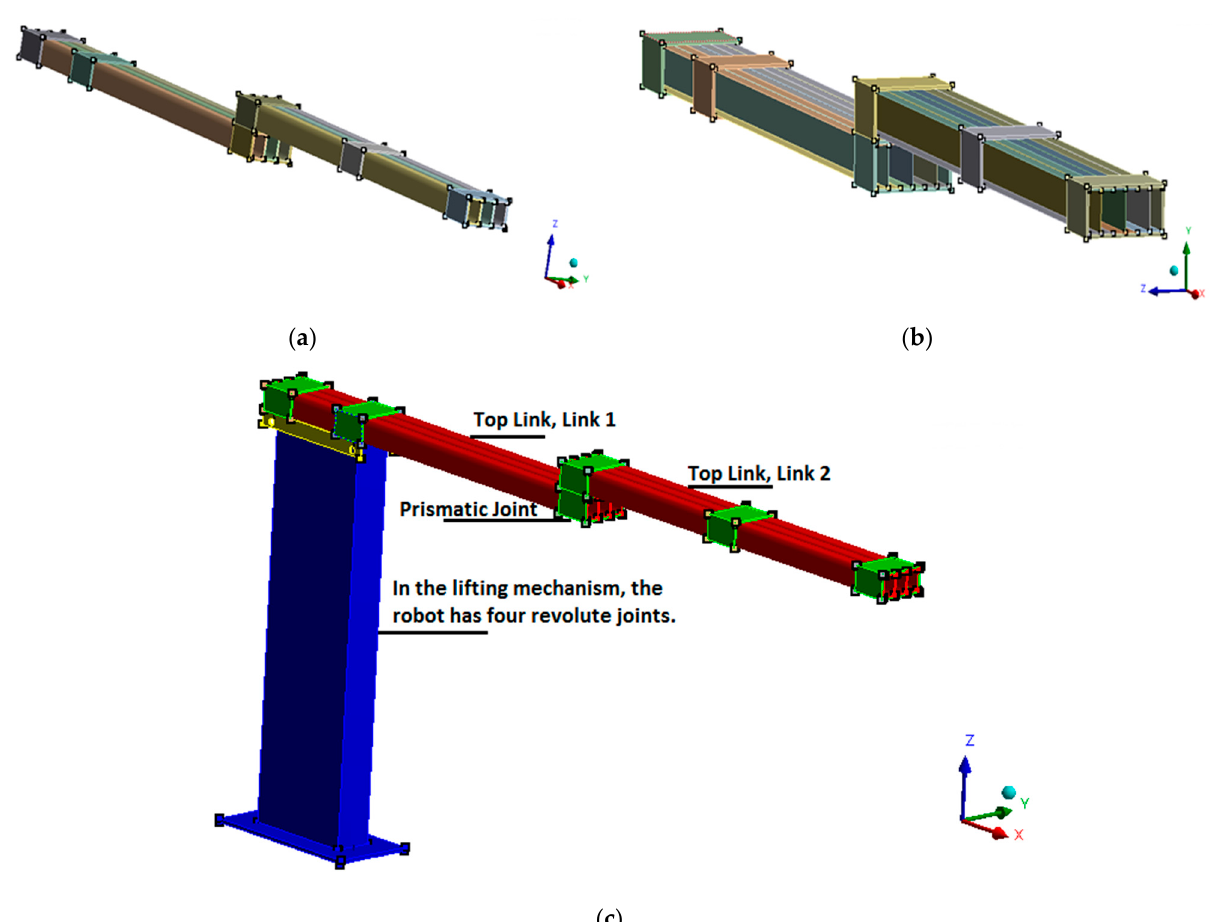
Figure 1. Schematic of the 5 ‐ DOF robot manipulator and its parts: ( a ) composite beams with three squared tubular sections (SSS) for the upper link of the manipulator, ( b ) composite beams with three I sections (III) for the upper link of the manipulator, and ( c ) the 5 ‐ DOF robot manipulator.